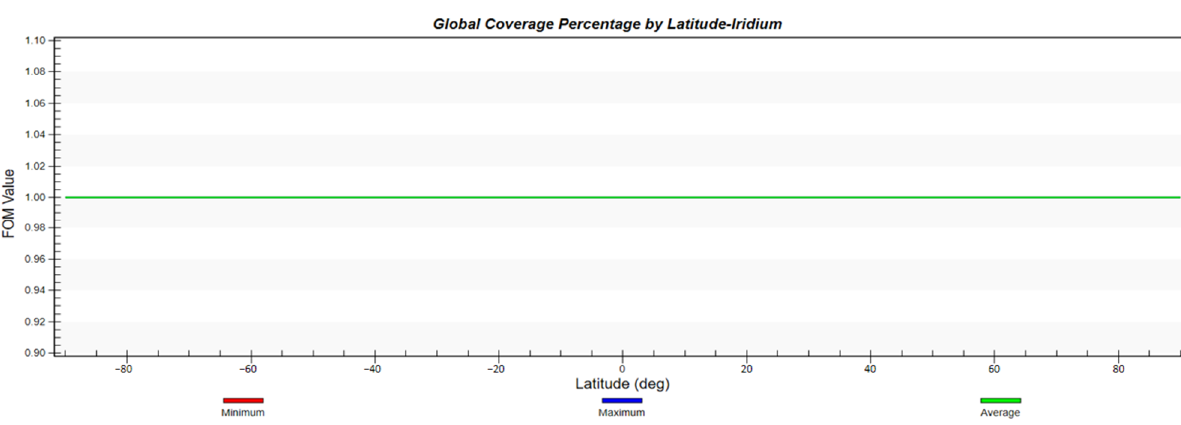
Figure 9. Global coverage percentage by latitude of Iridium constellation.